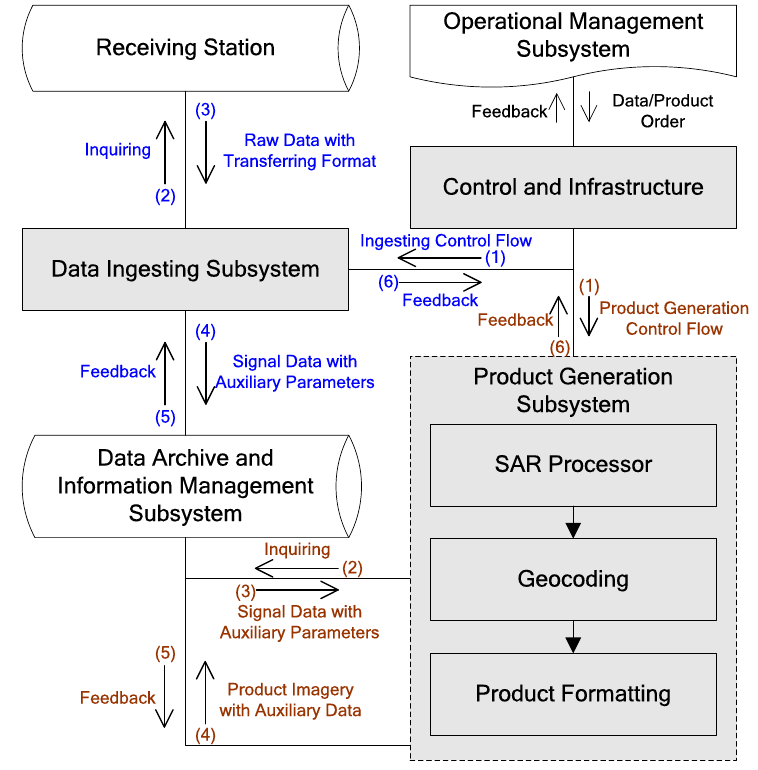
Figure 1. GF3DP software architecture.